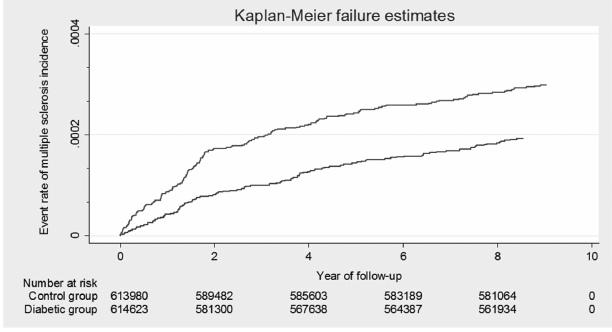
Fig. 2. Kaplan e Meier curves and estimates of multiple sclerosis incidence in the diabetes and comparison